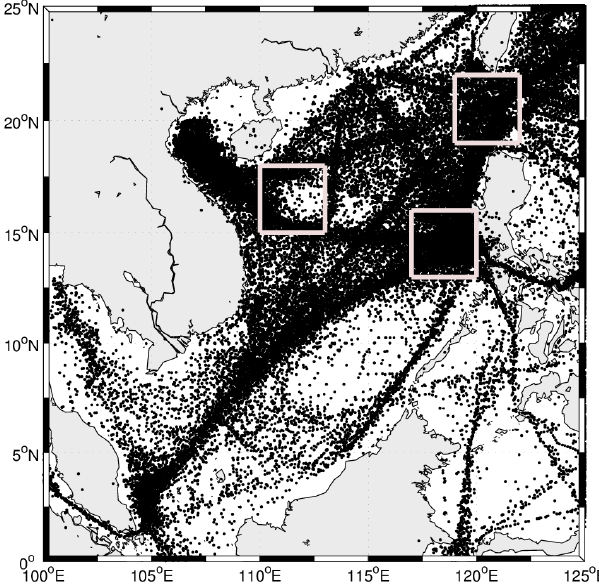
Fig. 1. Geographical distribution (asterisks) of the XBT data used Figure 1 . Geographical distribution (asterisks) of the XBT data used in this study, 314 in this study, which consist of more than 23000 profiles. The three which consist of more than 23,000 profiles. The three boxes are used for illustrating 315 boxes are used for illustrating spatial differences: Box 1 for the Lu- spatial differences: Box 1 for the Luzon Strait, Box 2 for west of Luzon Island, and 316 zon Strait, Box 2 for west of Luzon Island, and Box 3 for the Xisha Box 3 for the Xisha warm eddy. 317 warm 318